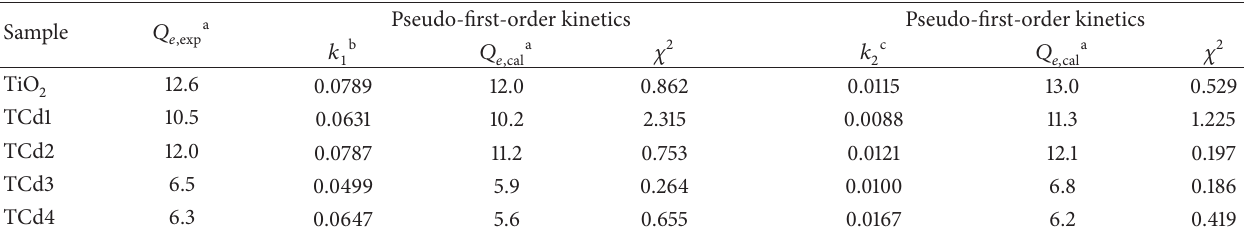
Table 4: Comparison of the pseudo-first-order, pseudo-second-order adsorption rate constants and calculated and experimental 𝑄 𝑒 values obtained at 100 mg/LMB concentration for the different photoadsorbents. Sample